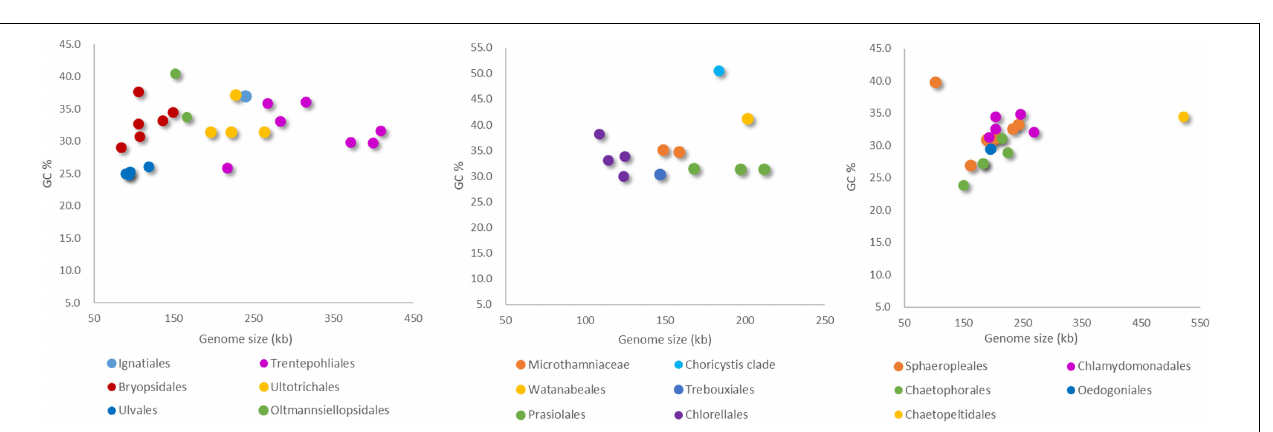
FIGURE 2 | Comparison of chloroplast genome size and GC content in Ulvophyceae (left), Trebouxiophyceae (middle), and Chlorophyceae